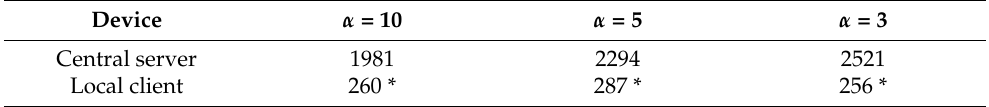
Table 2. Number of sent/received model parameters with different degrees of heterogeneity in FedTCM ( c t = 2), * denotes the result of averaging.